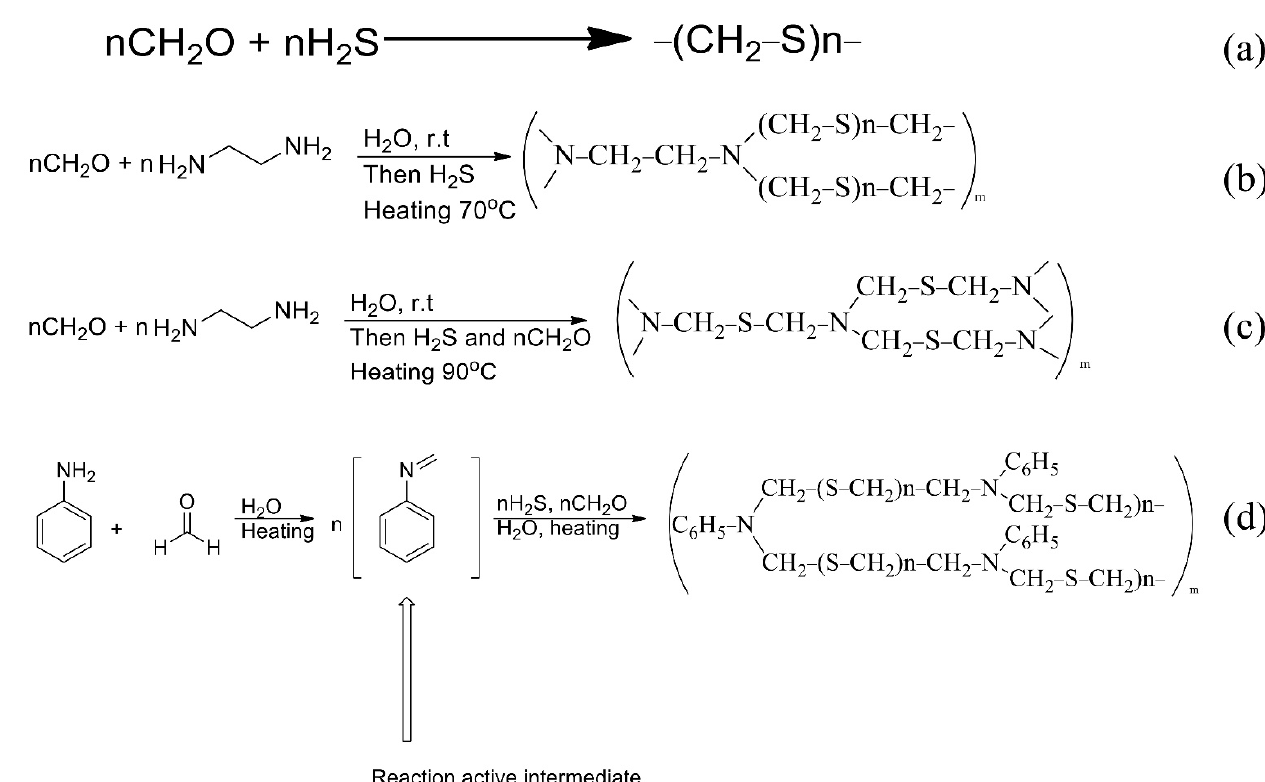
Figure 2. The schemes of reactions of synthesis of sorbents (( a ): PTE, ( b ): PED, ( c ): TDA, ( d ): PhED).